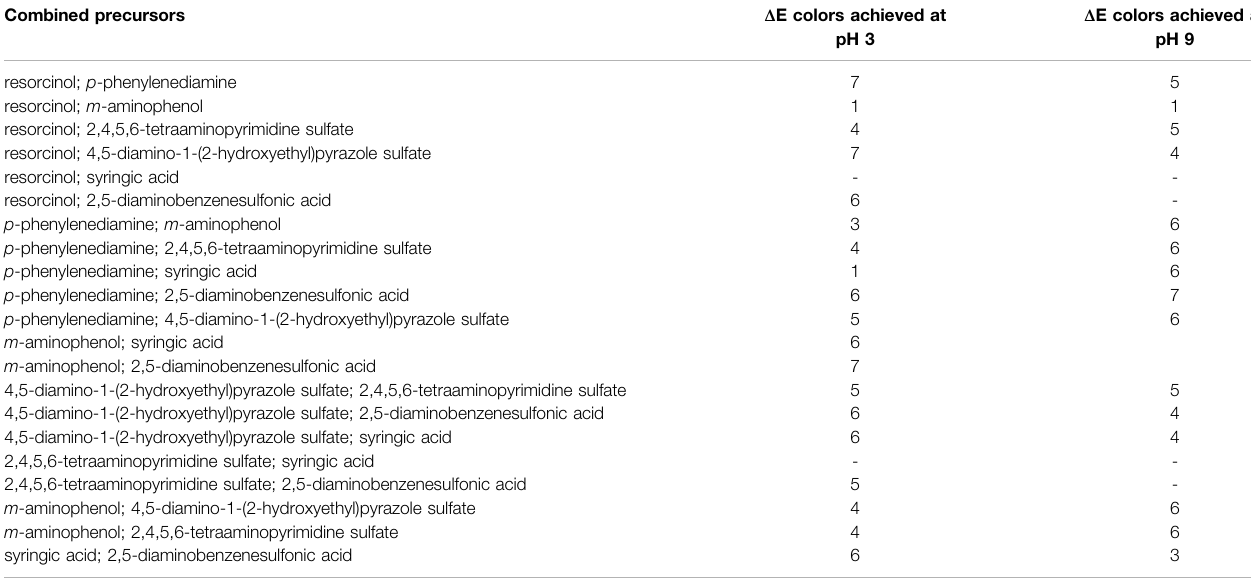
Δ E colors achieved at pH 3 pH 9